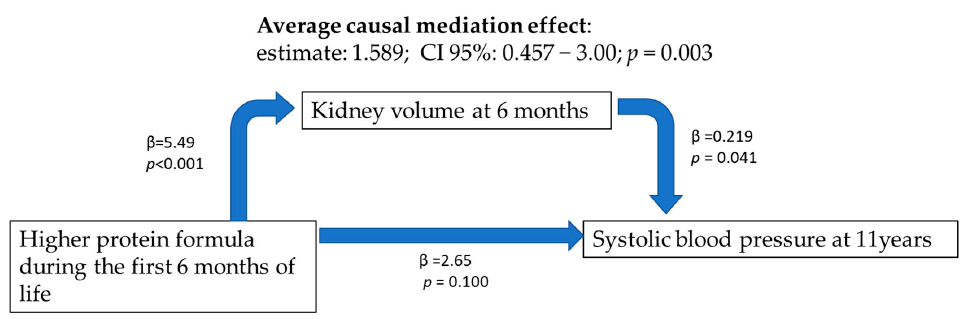
Figure 2. Mediation analysis on the effect of protein ingestion during the first months of life on systolic blood pressure at 11